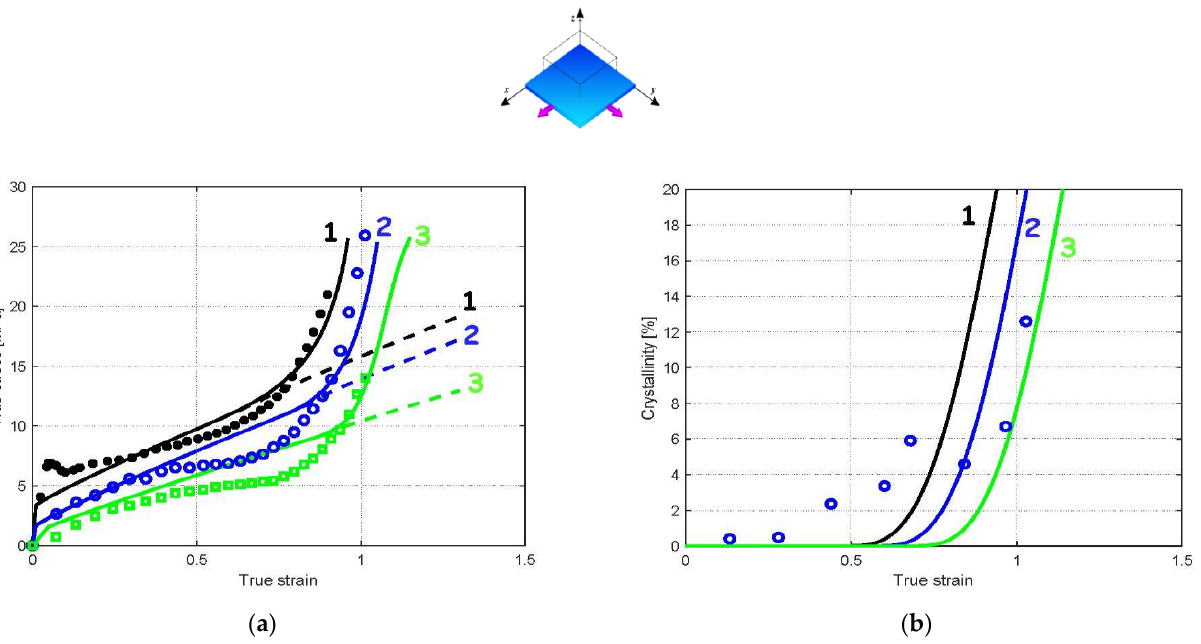
Figure 4. Model results under EB loading at a strain rate of 1/s and different loading temperatures (1: 83 °C, 2: 89 °C, 3: 94 °C): ( a ) stress – strain response, ( b ) strain-induced crystallization; solid lines: model; dashed lines: model with no crystallization; symbols: experimental data of Adams et al. [2].